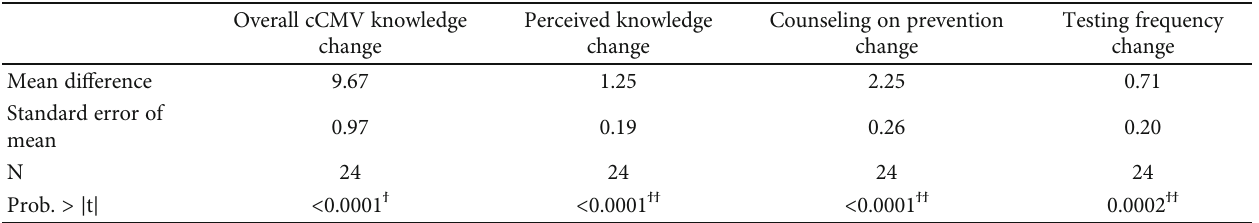
Table 3: Di ff erences of fi nal minus initial cCMV knowledge and fi nal minus initial Likert-type responses for the 24 dual survey